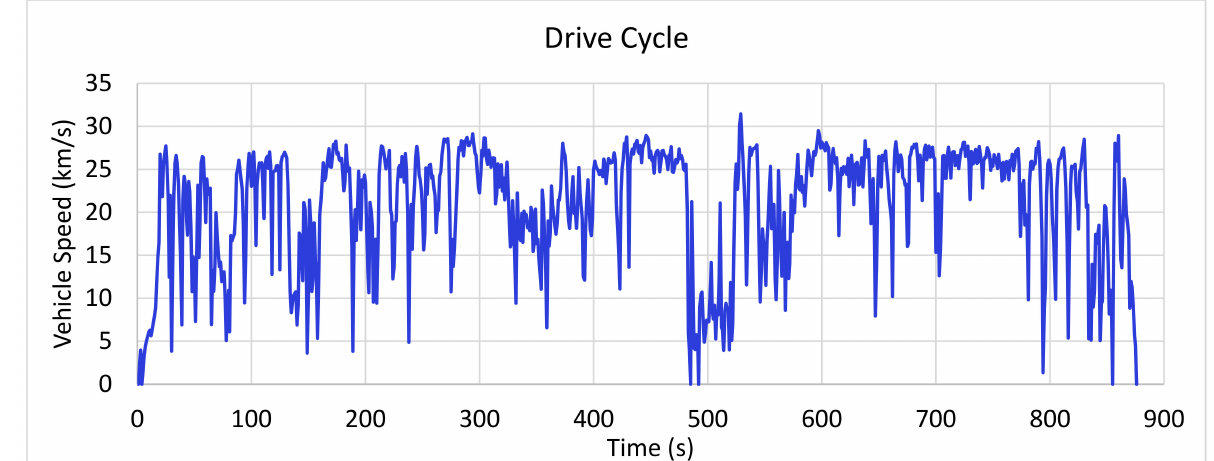
Figure 12. Driving Cycle chosen in Pune city for 16 km driving range.